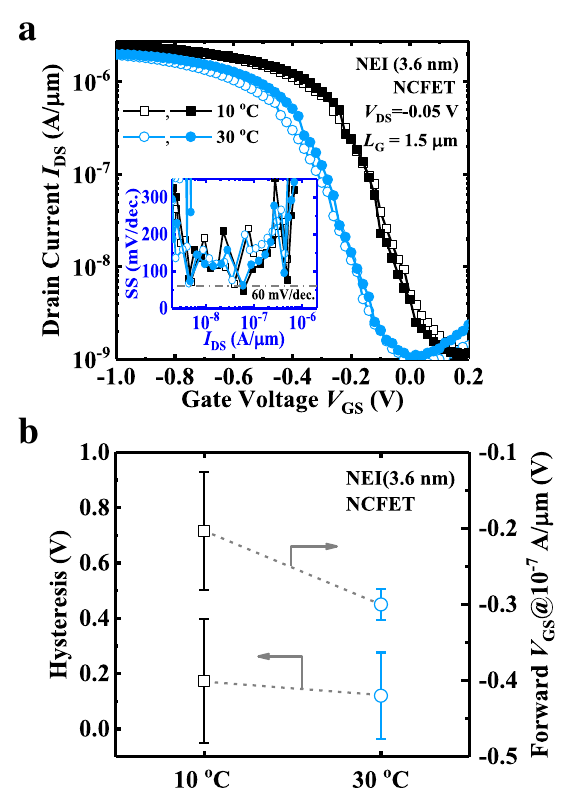
Fig. 9 a I DS - V GS of a NEI (3.6 nm) NCFET measured at 10 °C and 30 °C. The curves show a shift towards more negative voltage with increasing temperature, as expected. Inset shows steep point SS. b Statistical plots of hysteresis (left) and forward V GS @ 10 − 7 A/ μ m (right) for NCFETs with 3.6-nm NEI layer. Forward V GS shifts in the negative direction with increasing temperature